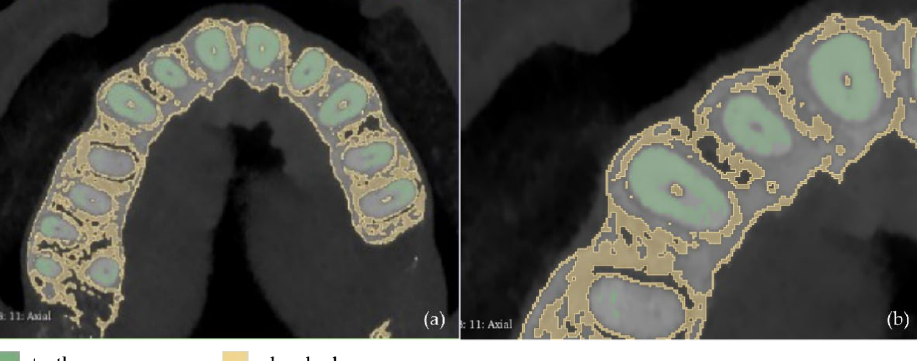
Figure 8. Automatic thresholding results (Experiment 3); ( a ): axial plane; ( b ): coronal plane; ( c ) sag- ittal plane.